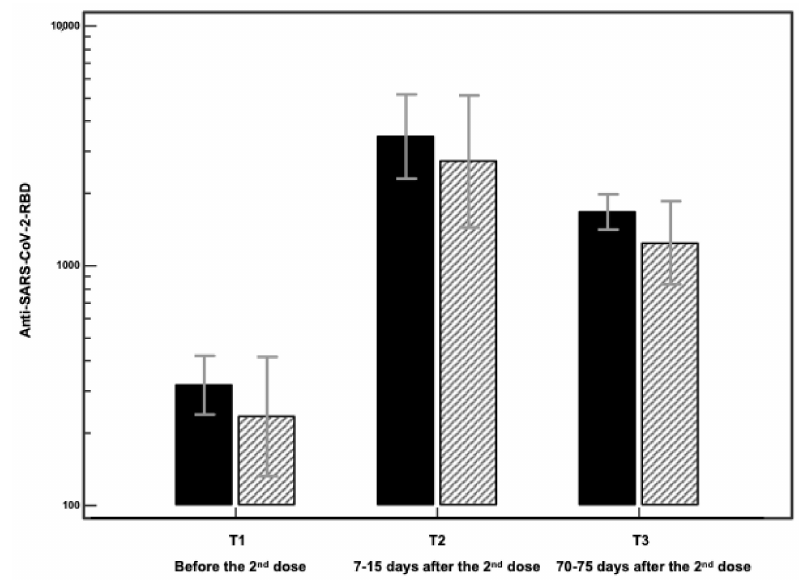
Figure 1. Antibody titers against the severe acute respiratory syndrome coronavirus 2 (SARS-CoV- 2)-receptor-binding domain (RBD) IgG titers expressed in arbitrary units (AU), measured 21 days after the first dose and before the second dose (T1), 7–15 days after the second dose (T2) and 70–75 days after the second and before the third dose of the vaccine (T3). Black bars: participants without diabetes; hatched bars: participants with diabetes. Data are shown as geometric means (95% confidence intervals). Anti-SARS-CoV-2-RBD: anti-SARS-CoV-2 receptor-binding domain